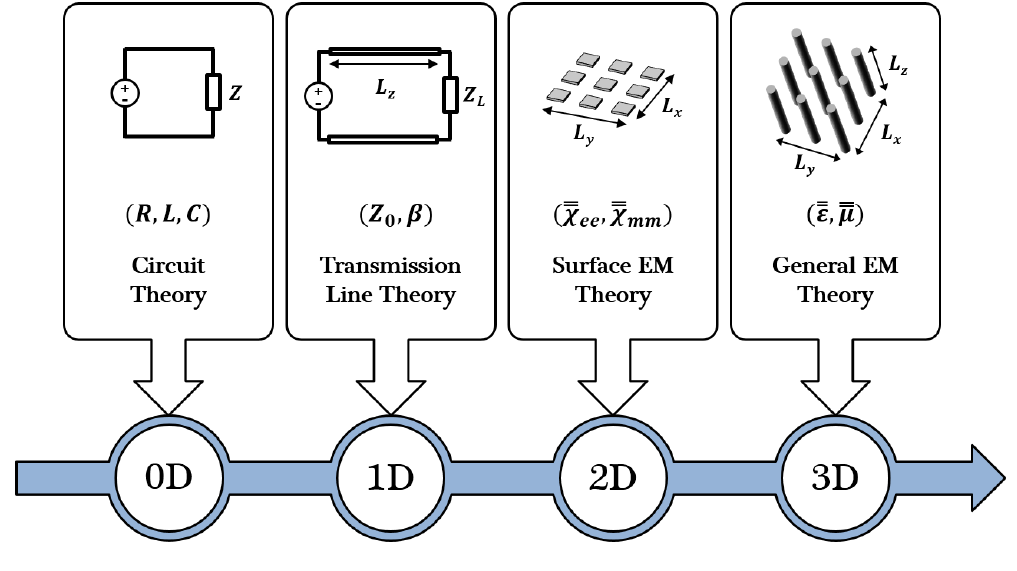
Figure 1. Classification of electromagnetic